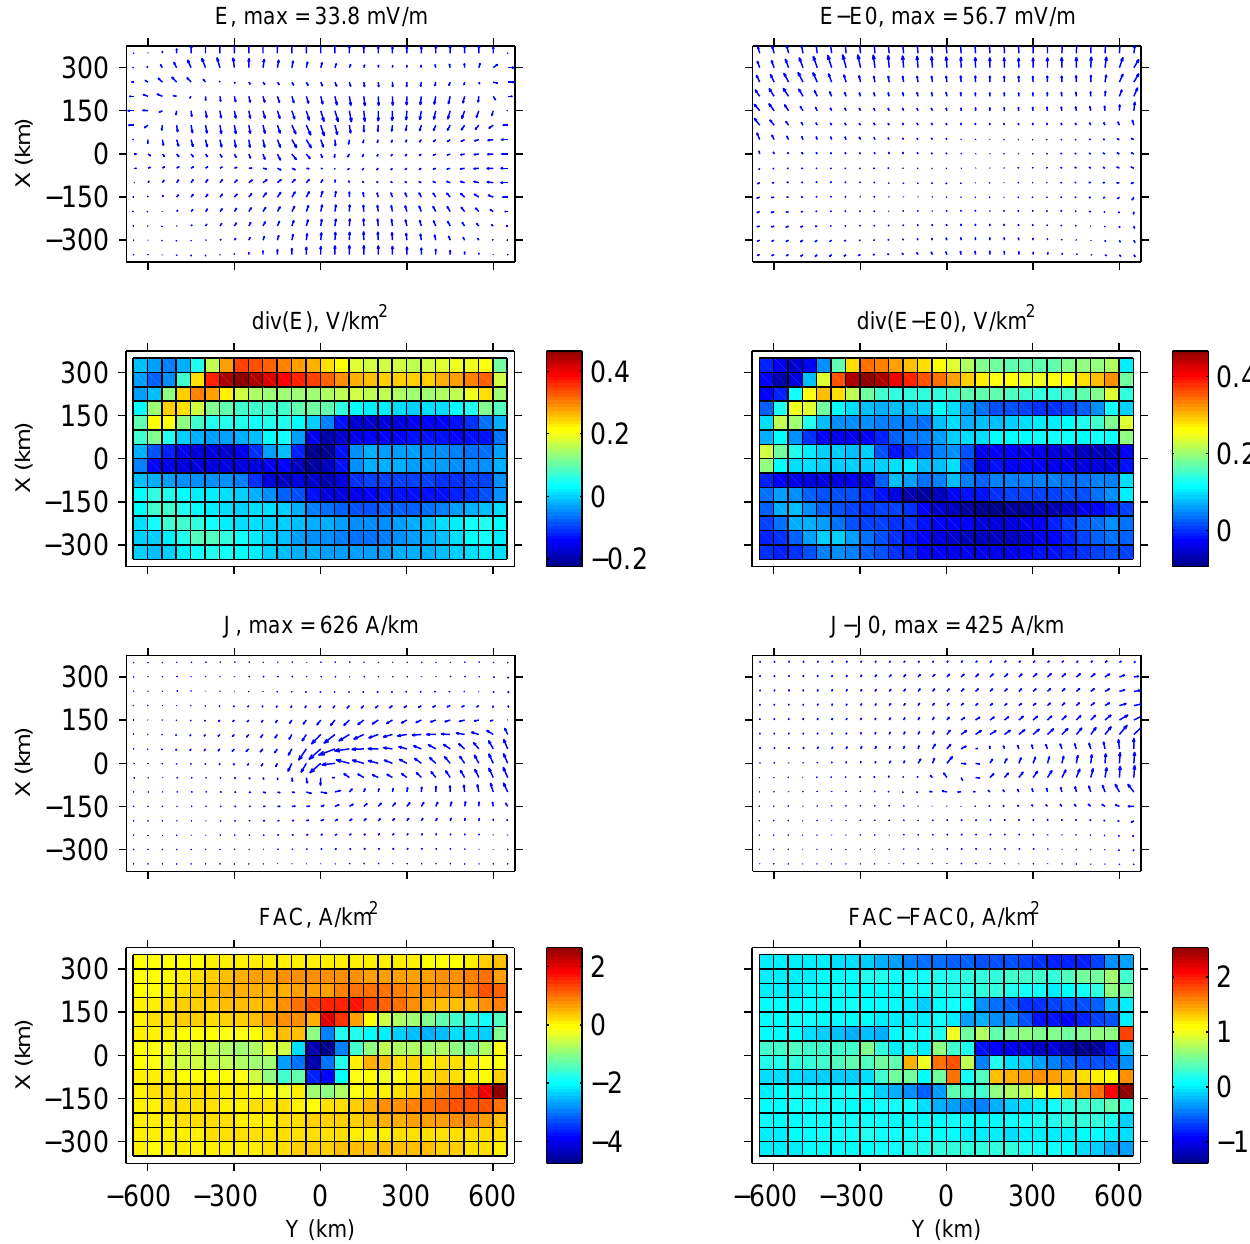
Fig. 9. KRM results for the WTS model. Layout is similar to Fig. 3. Note the different scales of the vector plots.